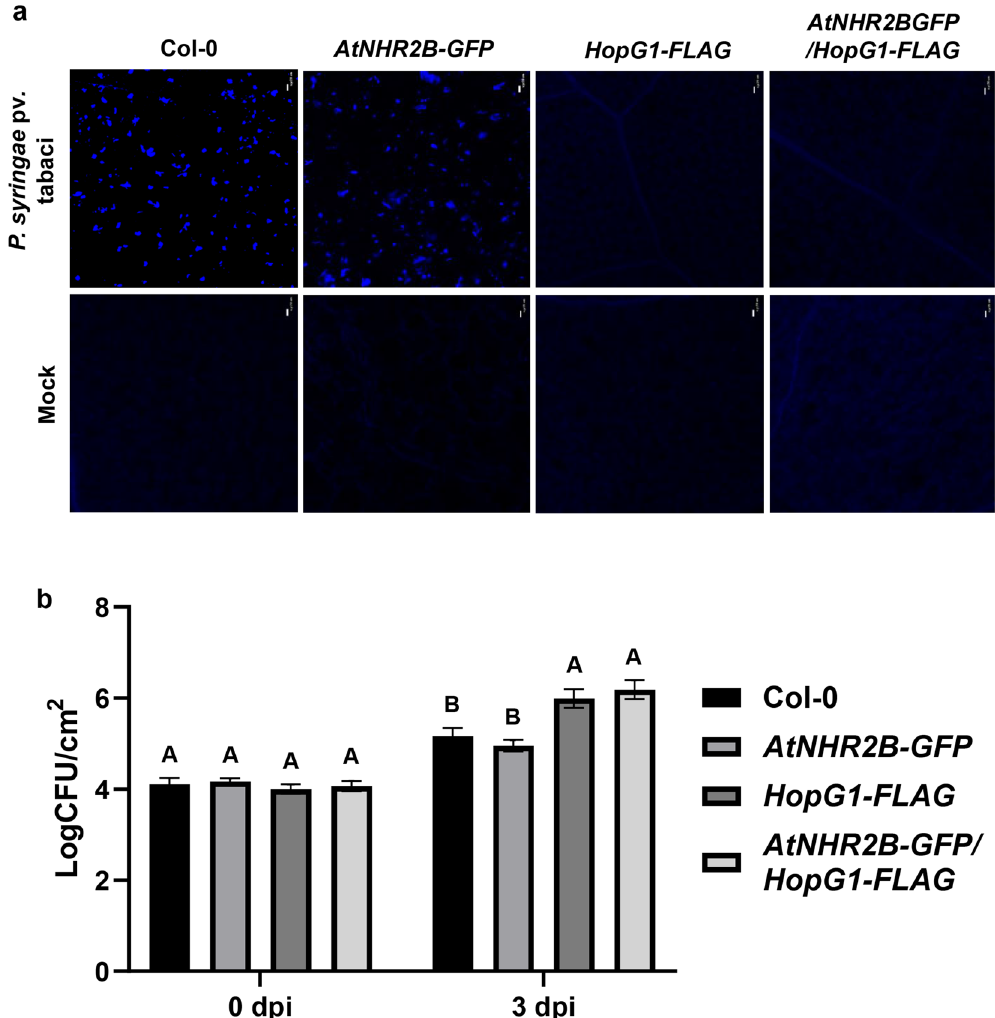
Figure 6. Transgenic expression of HopG1 interferes with AtNHR2B-dependent plant defense responses. ( a ) Plants expressing HopG1 are deficient in callose deposition. Five-week-old wild-type Col-0, AtNHR2B-GFP, HopG1-FLAG , and AtNHR2B-GFP/HopG1-FLAG were syringe-inoculated with the non-adapted bacterial pathogen Pstab at a concentration of 1 × 5 /ml. HopG1-FLAG and AtNHR2B-GFP / HopG1-FLAG were sprayed with 20 μM DEX 24 h prior to bacterial inoculation. Inoculated leaves were detached at 24 hpi and stained with 5% aniline blue staining to evaluate callose deposition. Images were taken using a confocal microscope under DAPI filter. Scale bar = 20 μm. ( b ) Transgenic expression of HopG1- contributes to bacterial growth. Wild-type Col-0, AtNHR2B-GFP, HopG1-FLAG , and AtNHR2B-GFP/HopG1-FLAG were syringe inoculated with Pstab at a concentration of 1 × 10 6 CFU/ml. HopG1-FLAG and AtNHR2B-GFP / HopG1-FLAG were sprayed with 20 μM DEX 24 h prior bacterial inoculation. Leaf samples were collected at 0 and 3 dpi. Bars represent means of CFU/cm 2 . Different letters above bars represent statistically significant difference in bacterial growth among plant genotypes using a one-way ANOVA and Tukey’s multiple comparison test with P-value ≤ 0.05. All above experiments were repeated three times with similar